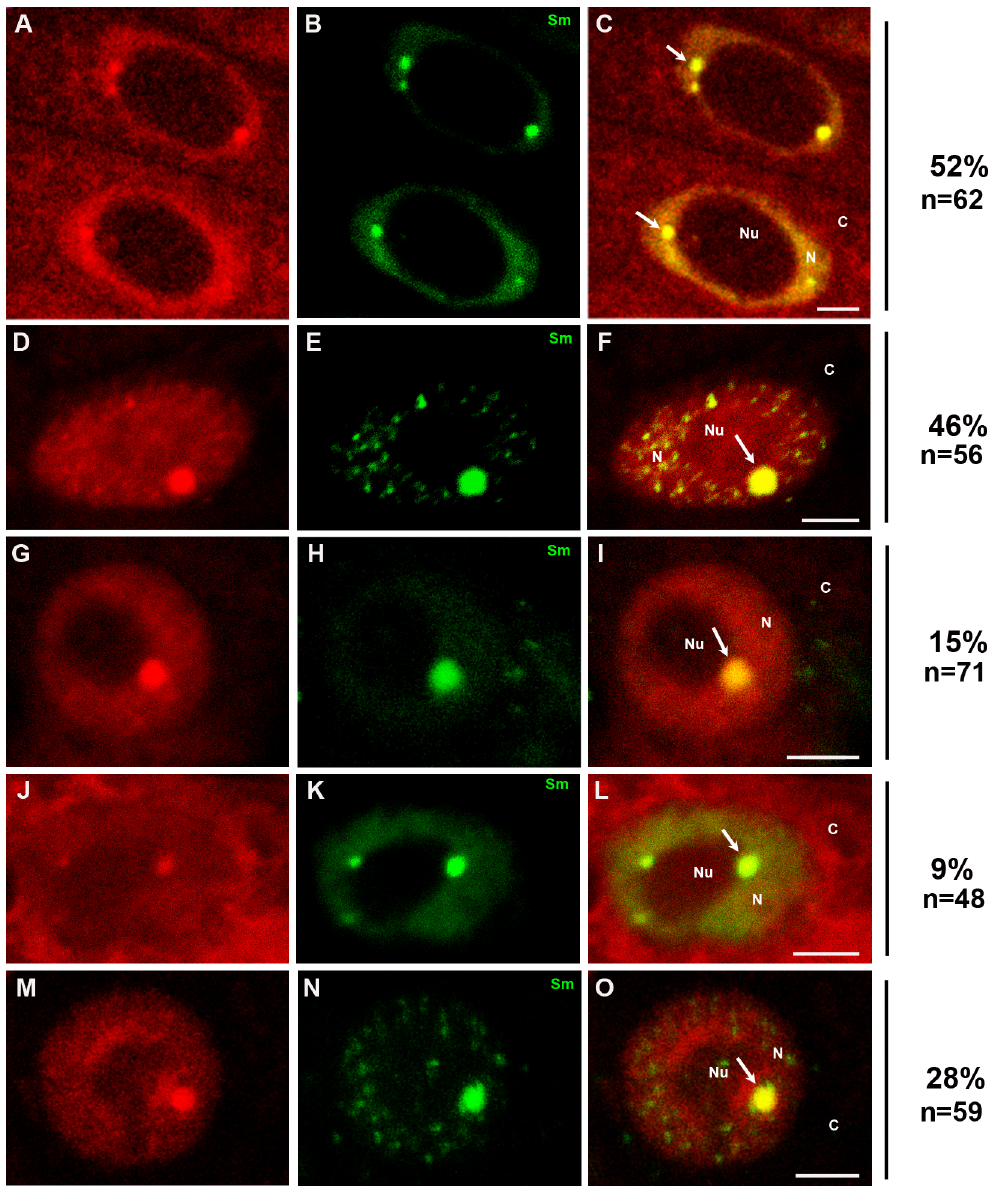
Figure 4. Double labelling of a mixture of four mRNAs (A, C) and distinct genes: cyclin B1 mRNA (D, F), peroxidase mRNA (G, I), cytokinin-specific binding protein mRNA (J, L) and pectin methylesterase mRNA (M, O), with Sm proteins (B, E, H, K, N) in Lupinus cells. The arrows indicate colocalisation of mRNA transcripts with CBs. A stronger signal was observed in the cytoplasm than in the nuclei after in situ hybridisation with the mixture of probes (A, C) and with a probe against cytokinin-specific binding protein mRNA (J, L). % indicates the percentage of nuclei showing the representative immunolocalisation pattern. Bar, 5 m m. N-nucleus, Nu- nucleolus, C- cytoplasm.